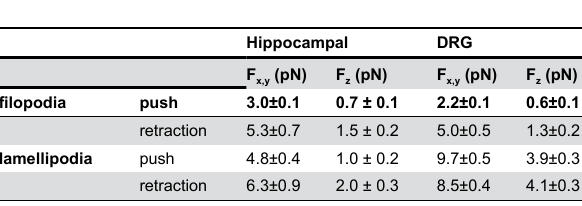
Values represent the mean ±